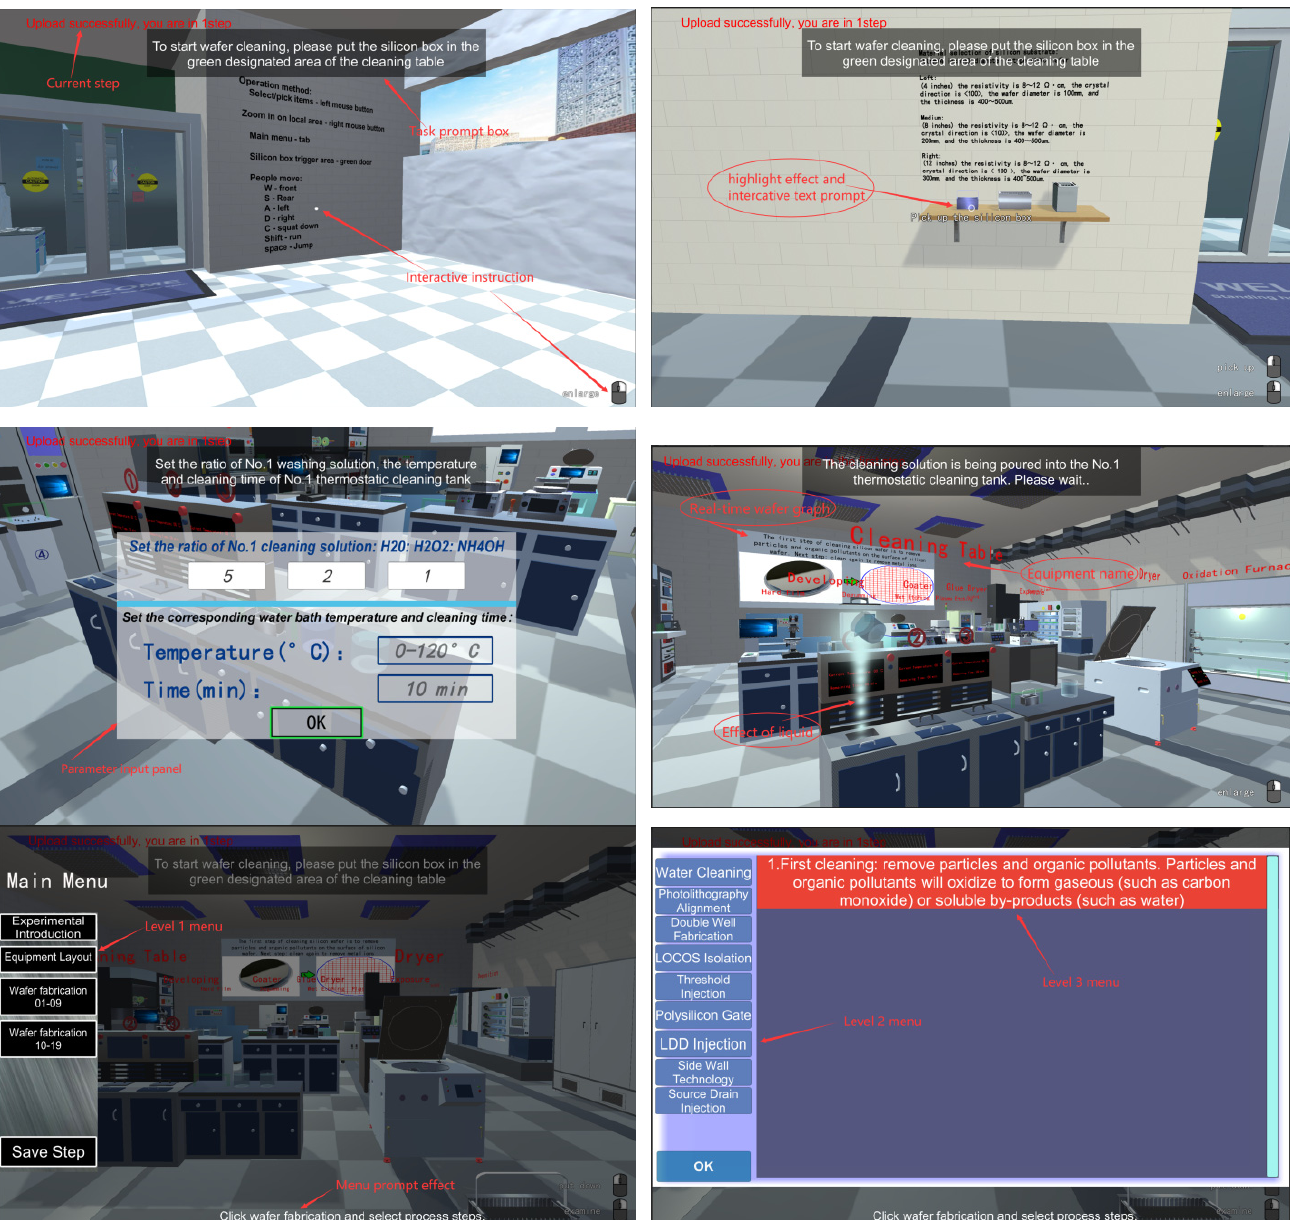
Figure 9. Overall functional structure diagram of the interaction design. Compared with the dotween plug ‐ in, animator is the most basic animation develop ‐ ment system of Unity3d [37]. Trigger is commonly used in animator to switch from one animation state to another. The first is the add animation event. Enter the animation panel, select the animation clip you need to monitor, select the triggered key frame, right ‐ click to add the animation event, and then select the function you need to trigger. In this way, when the animation plays to this frame, it will trigger the function you choose. Other corresponding performance effects can be seen in Figure 10 below.